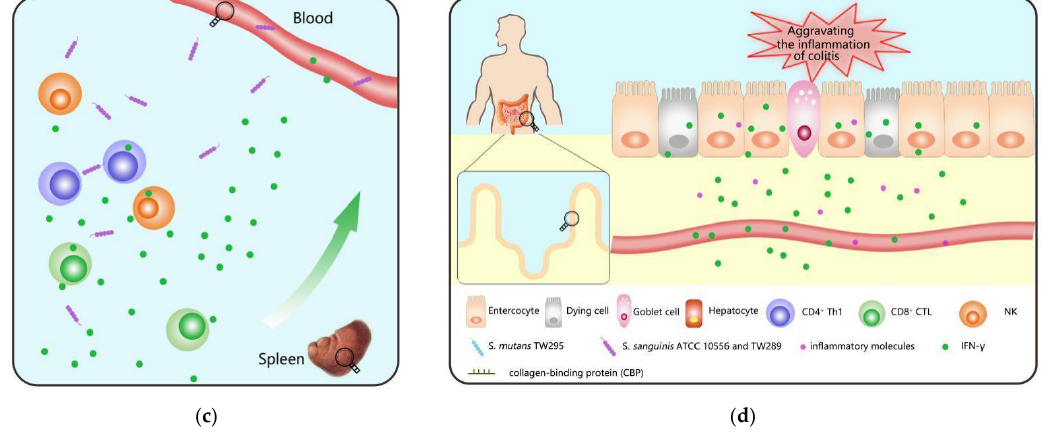
Figure 2. Pathogenesis of Streptococcus spp. in IBD. ( a ) S. mutans and S. sanguinis can enter the bloodstream from the oral cavity through daily dental activities or invasive dental treatments. ( b ) After circulating to the liver, S. mutans TW295 can express CBP to achieve adhesion and invasion of hepatocytes, which then respond to this stimulation by producing IFN- γ and subsequently leading to the release of all sorts of inflammatory molecules cytokines. ( c ) S. sanguinis ATCC 10,556 and TW289 may activate the Th1 response, inducing T cells to express IFN- γ, especial ly CD4 + Th1, CD8 + CTL, and NK cells predominantly in the bloodstream or spleen. ( d ) Inflammatory molecules and IFN- γ produced by both bacteria travel through the bloodstream to the colon, aggravating the inflammation of colitis.